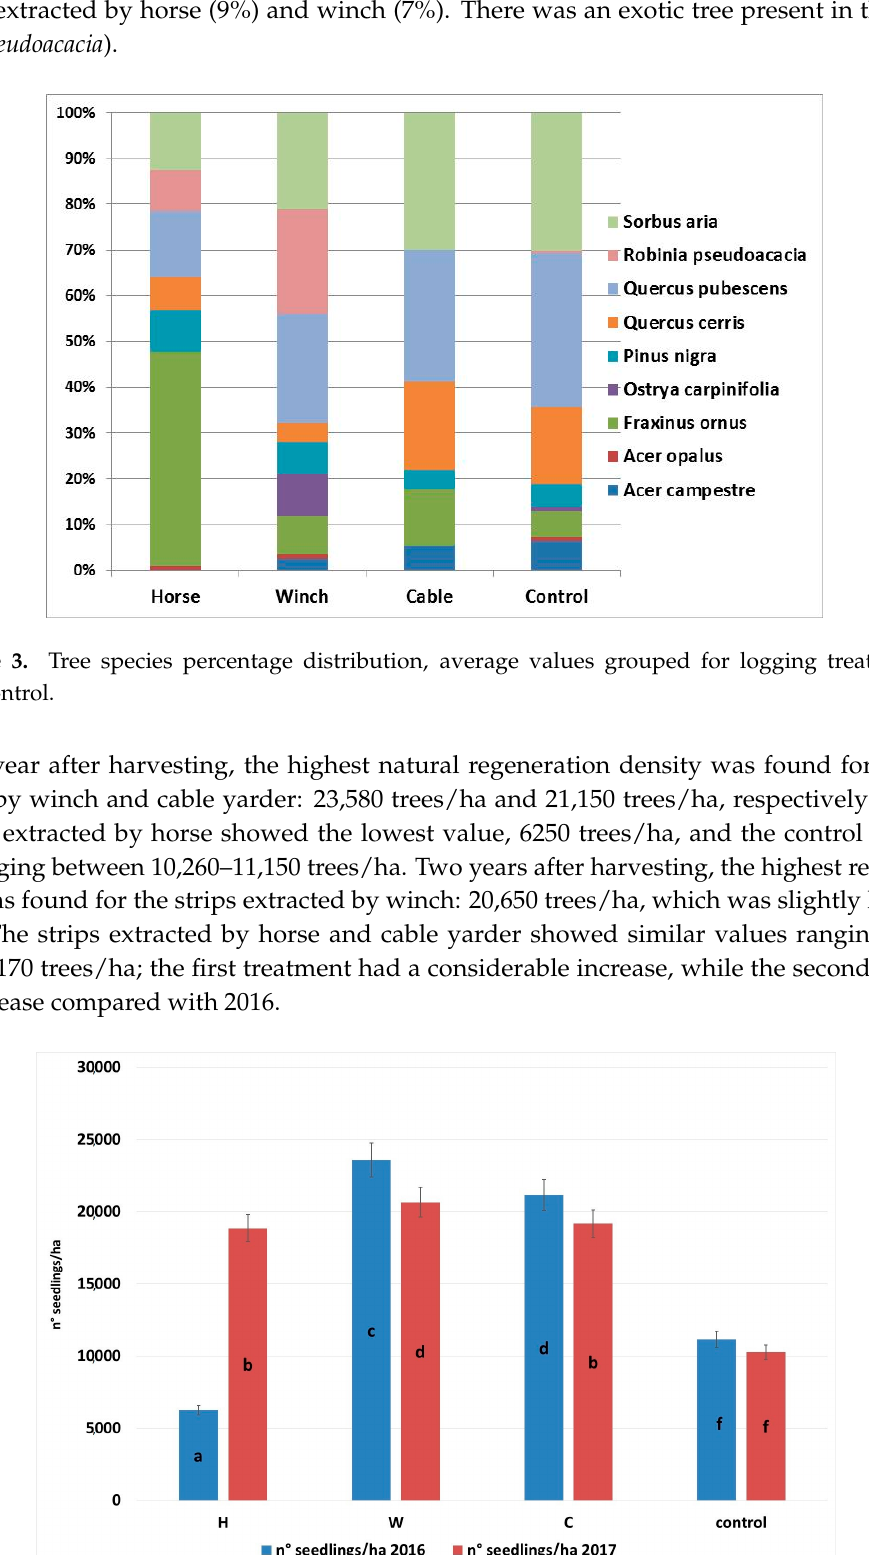
Figure 4. Tree regeneration density, average values with standard deviation for the different treatments, one year after harvesting (2016) and two years after harvesting (2017). ANOVA results shown statistically significant differences, p < 0.05 and the Tukey test applied found five groups, showed by different